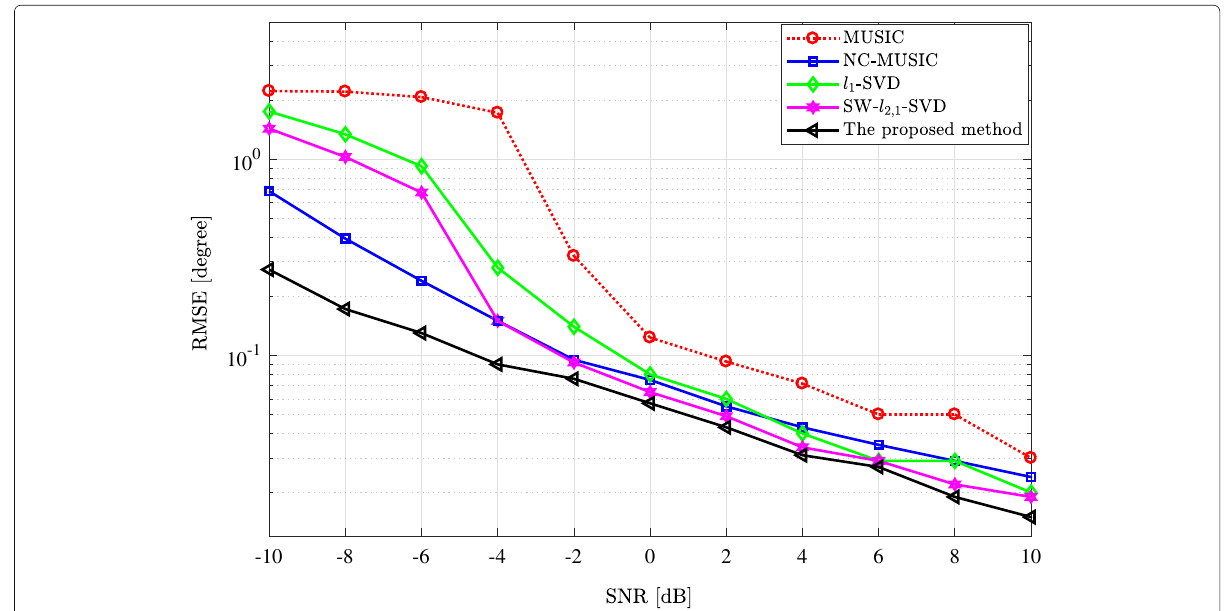
Fig.3 RMSEs of MUSIC, NC-MUSIC, l 1 − SVD, SW − l 2,1 − SVD, and the proposed method as a function of SNR in the Gaussian white noise for N =